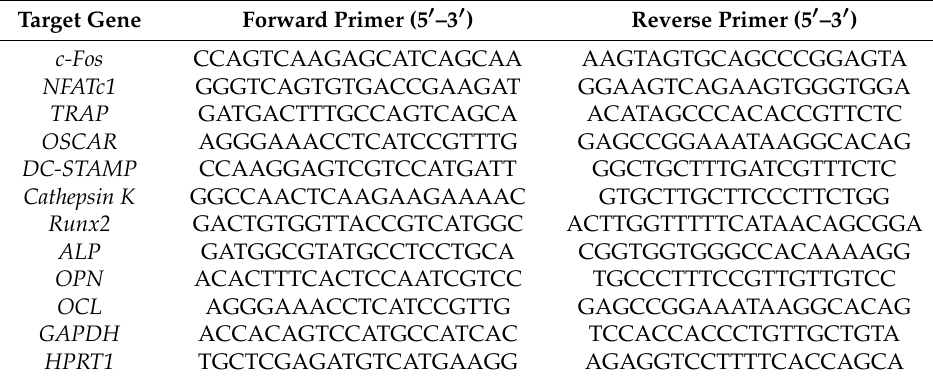
Table 1. The primer sequences used in this